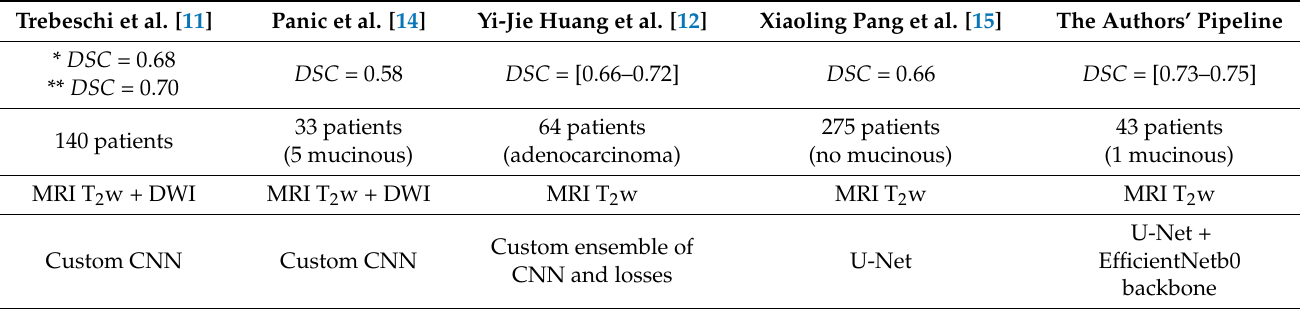
Table 2. Comparison between state-of-the-art pipelines for the automated segmentation of rectal cancer. All the results of the comparison are expressed in terms of the DSC score. The last column reports the results obtained by the proposed pipeline regarding the data involved in the present study. In relation to the study of Trebeschi et al., the DSC score obtained by the two experts involved in the study (i.e., expert 1 (*) and expert 2 (**) is